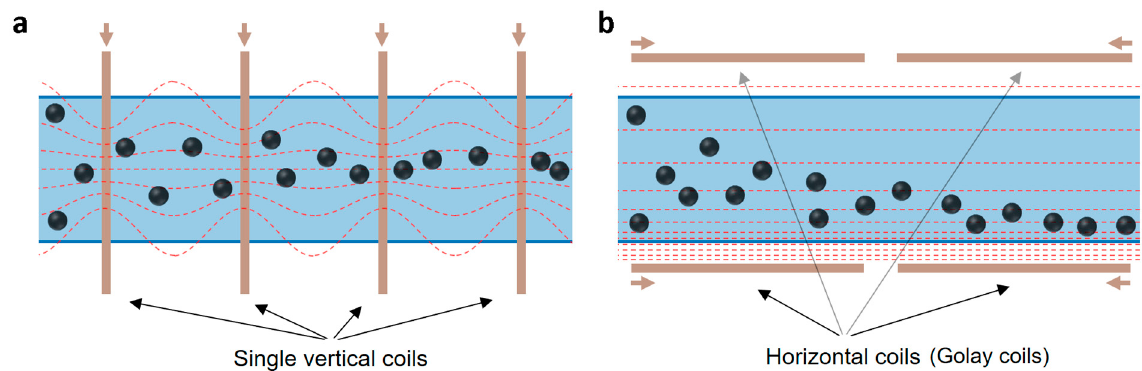
Figure 2. Alternative separator designs with external electromagnets (arrows point in the direction of the current) using ( a ) spaced single coils (radial gradient between single coils) and ( b ) horizontal coils in the Golay arrangement (vertical gradient). All field lines shown (dashed lines) are for illustration.